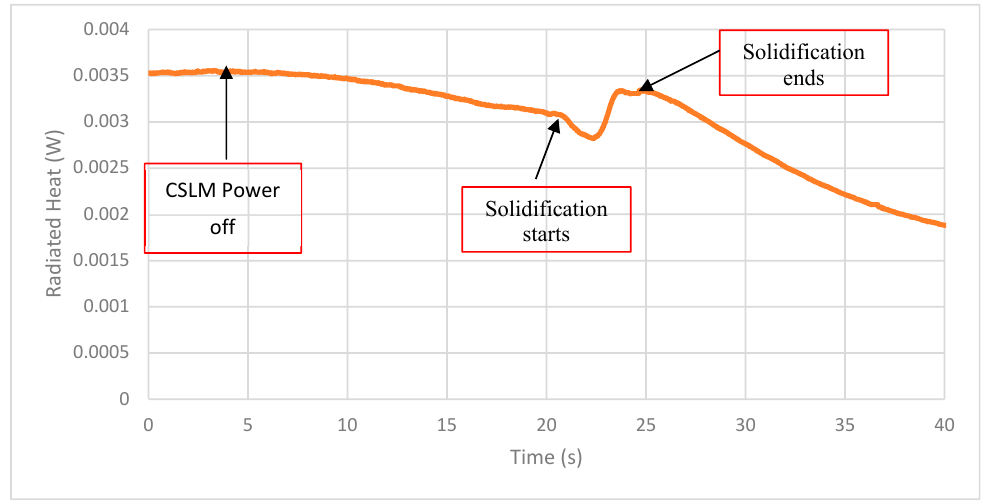
Figure 3. Radiated heat curve for the surface of the steel sample that was solidified in